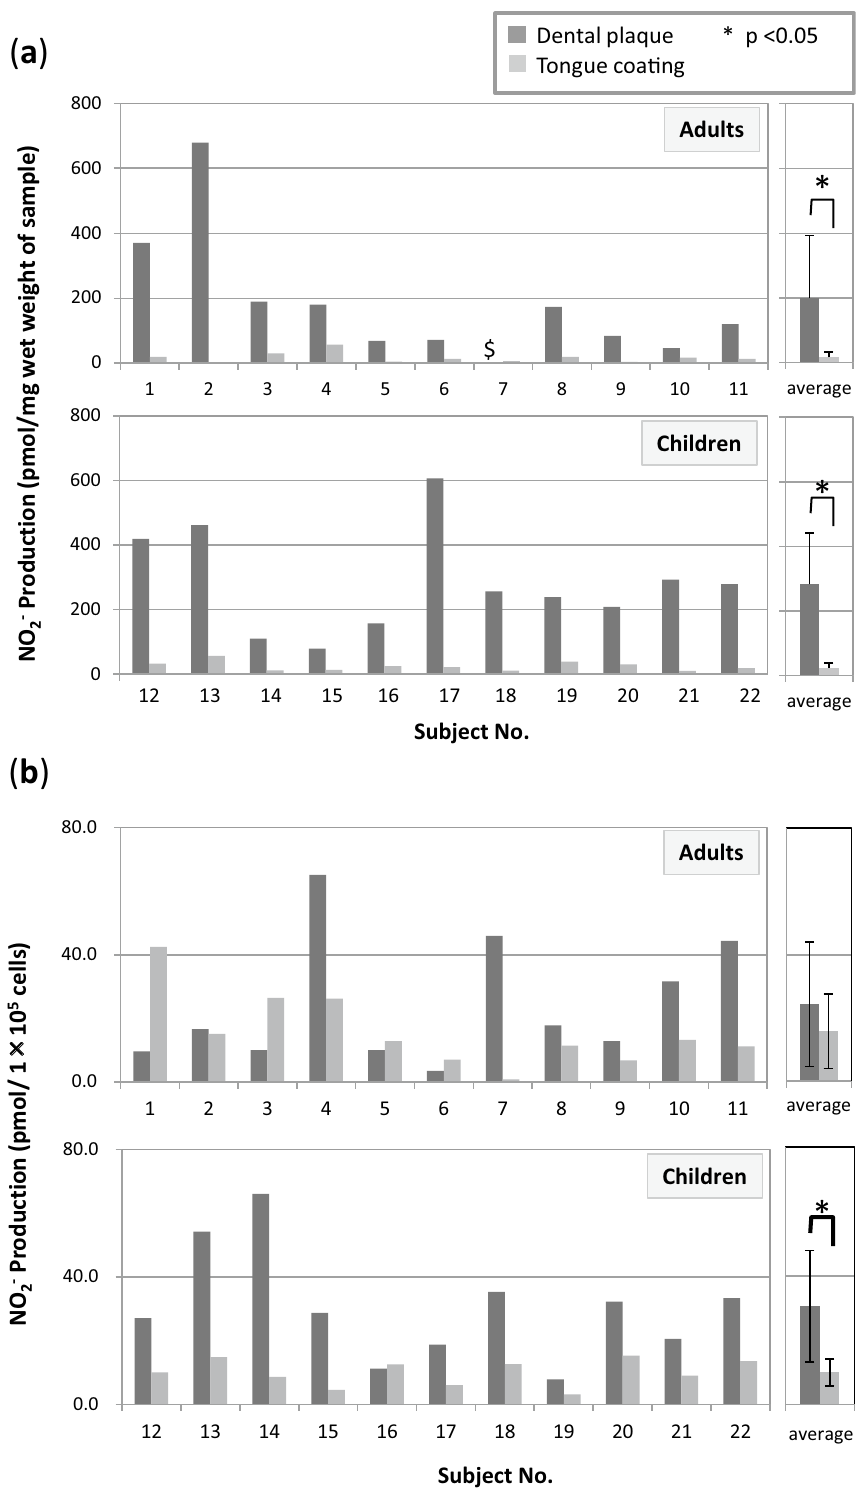
Figure 1. ( a ) The NO 2− -producing activity of dental plaque and tongue-coating samples (pmol/mg wet weight). ( b ) The NO 2− -producing activity of dental plaque and tongue-coating samples (pmol/1 × 10 5 cells).